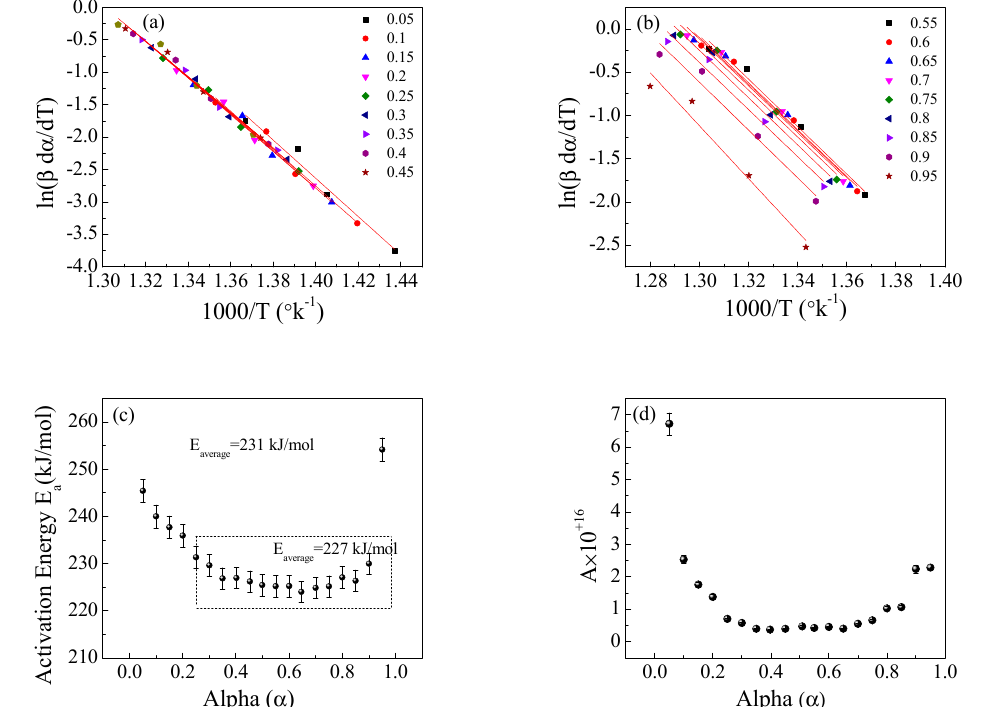
energy changes when alpha is less than 0.4. There is no specific behavior for the three samples within this range ( α < 0.4). Figure 10. The Friedman method for EPDM host composite: ( a , b ) ln( β d α /dT) versus 1000/T; ( c , d ) the dependence of Ea and A, respectively, on α . In accordance with the E( α ) relation for the three methods mentioned above, there is a region where the activation energy dependence on the degree of conversion ( α ) is weak or not significant and can be considered constant after looking at the value of its standard deviation (0.64, 0.53, and 3.31, respectively). The average activation energy for each method is close to those of the Kissinger and Augis–Bennett methods, with a slight dif- ference not exceeding 5%, as shown in Table 3. Table 3. The average activation energy values for the EPDM host composite.